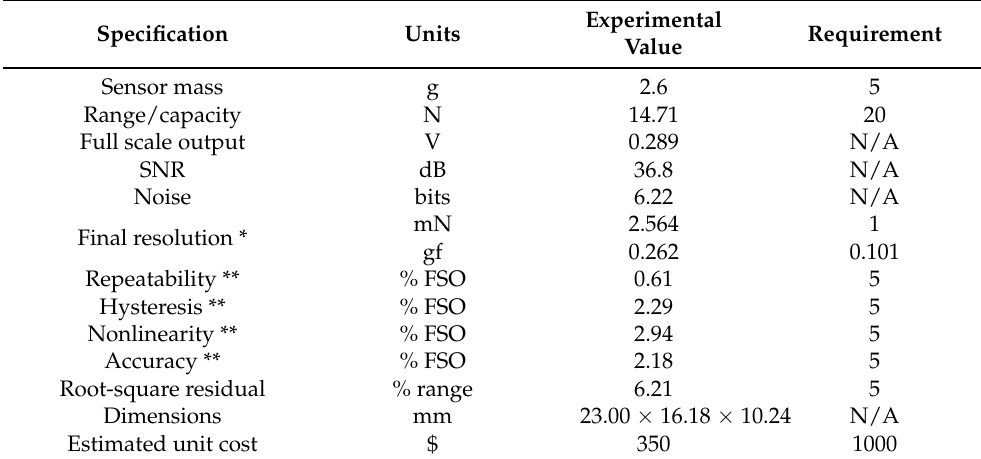
Table 6. Experimentally-obtained specifications for a representative 3-DOF fingertip sensor, with comparison to original